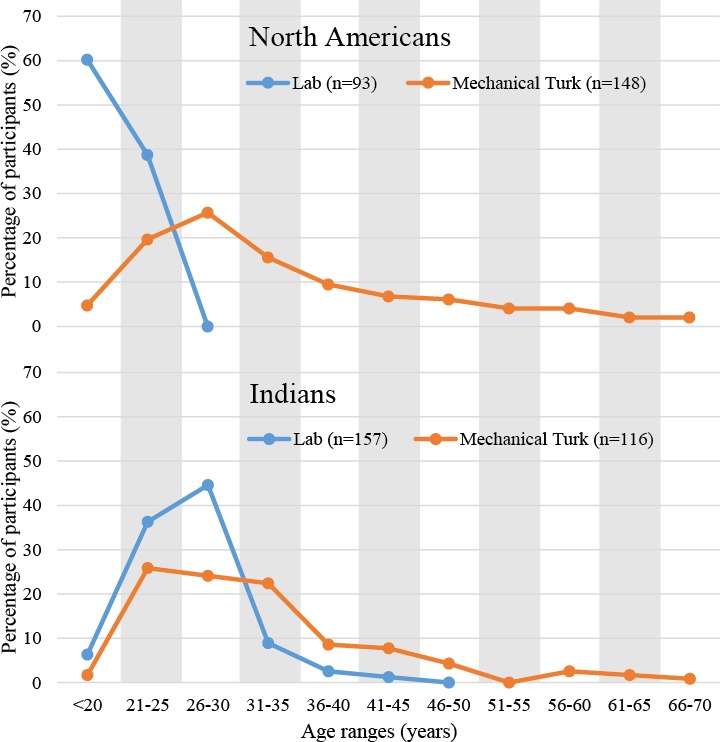
The distribution of ages for US and Indian participants recruited via Mechanical Turk or tested in a lab-based setting in the USA and India (Woods et al., 2015).